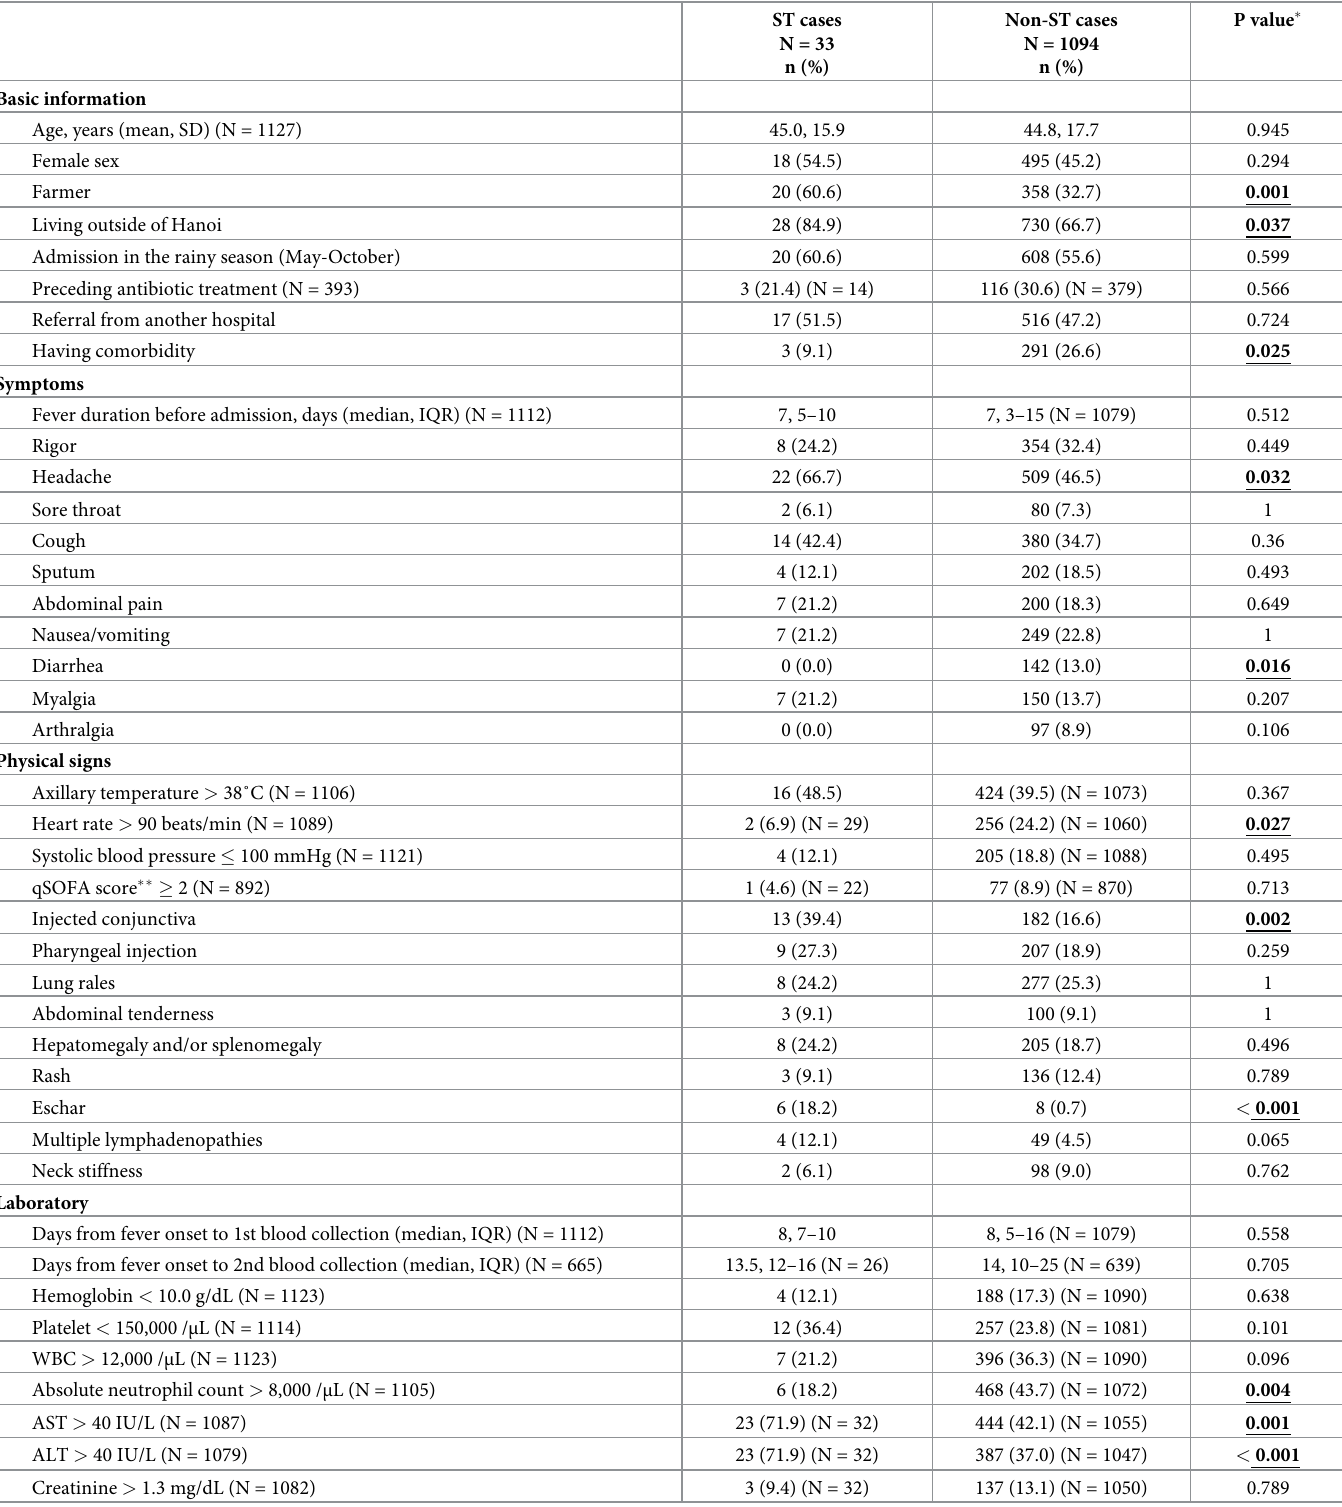
Table 1. Comparison of the demographic and clinical